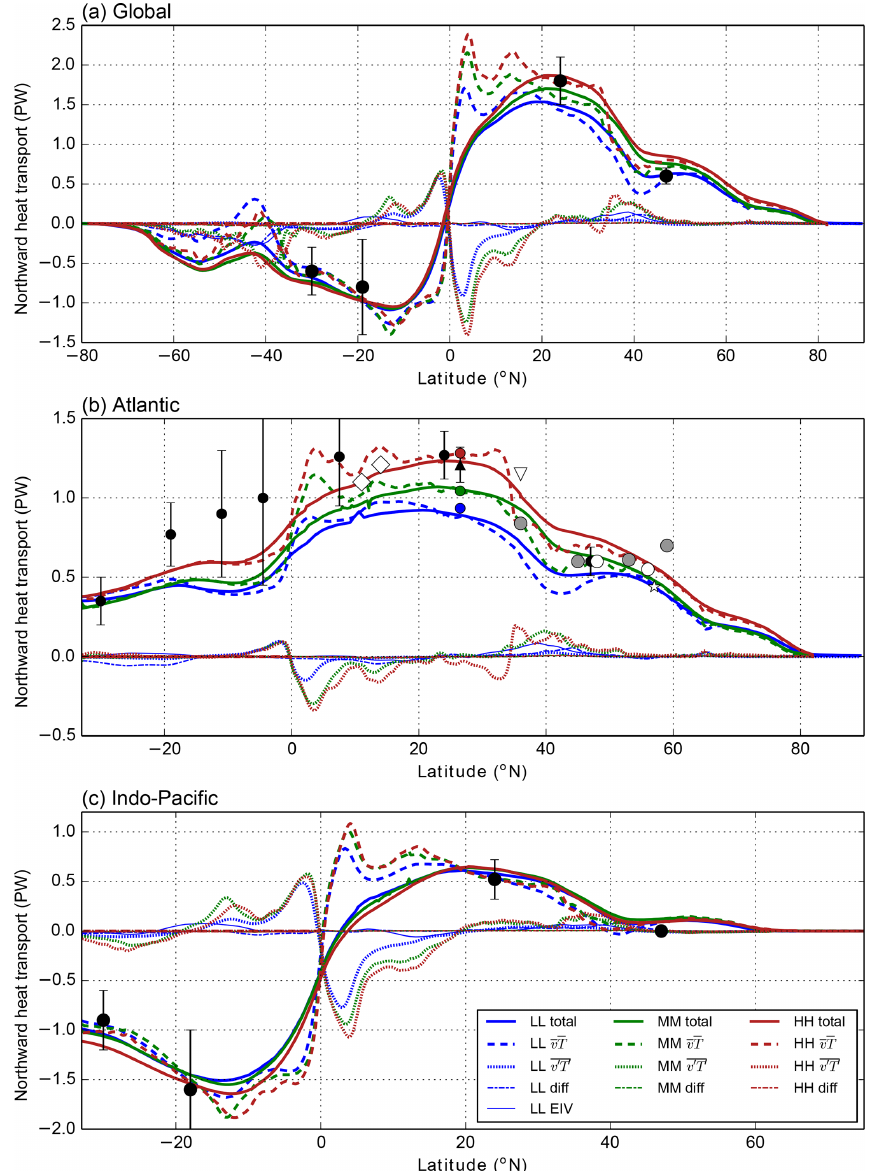
Figure 17. Ocean northward heat transport for (a) global, (b) Atlantic and (c) Indo-Pacific basins, averaged over years 50–100, separated into components: total (thick solid lines) is comprised of mean resolved advection (thick dashed lines), eddying advection (dotted lines), diffusion (Diff, thin dash-dot lines) and parameterised eddy-induced velocity (EIV, thin solid lines). The MM and HH models do not have a separately diagnosed EIV, as its parameterisation (Gent–McWilliams scheme) is switched off. For global and Indo-Pacific basins, the black circles and lines are observational estimates from Ganachaud and Wunsch (2003) with uncertainty. For the Atlantic, the black circles and lines are observational estimates from Ganachaud and Wunsch (2003) with uncertainty; the black triangle is RAPID-MOCHA (Johns et al., 2011); white diamond – Bryden and Imawaki (2001); gray circle – Talley (2003); white open circle – Lumpkin and Speer (2007); white inverted triangle – McDonagh et al. (2010); white star – Lozier et al. (2019). The coloured circles in panel (b) at 26.5 ◦ N correspond to the mean values using the RapidMoc calculation as in Fig.